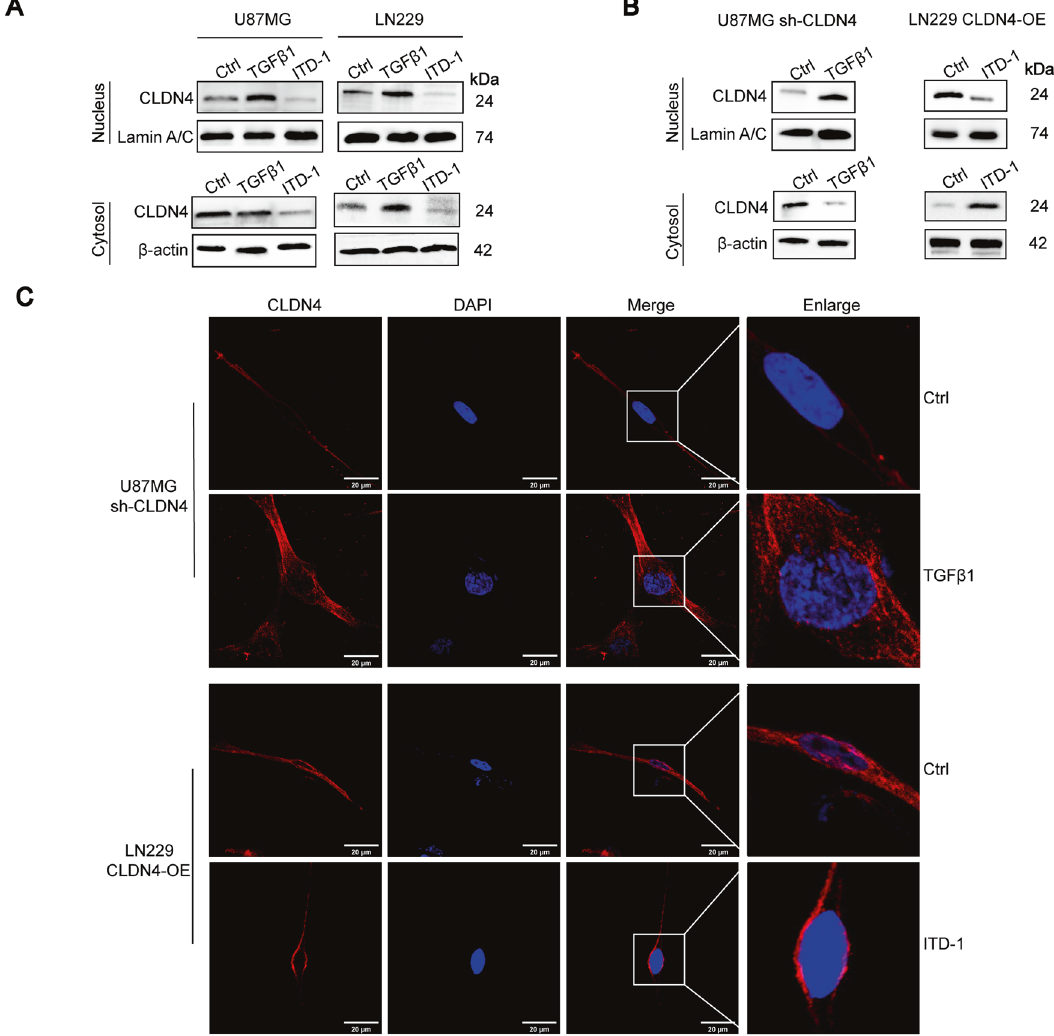
Fig. 6 TGF β 1 can promote CLDN4 nuclear accumulation. A , B The cytosolic and nuclear CLDN4 were determined by western blotting assays. C Double immuno fl uorescence staining of CLDN4 (red) and DAPI (blue) in GBM cells derived from the untreated or treated experimental groups. Representative images of three cases were shown. Scale bar represents 20 μ